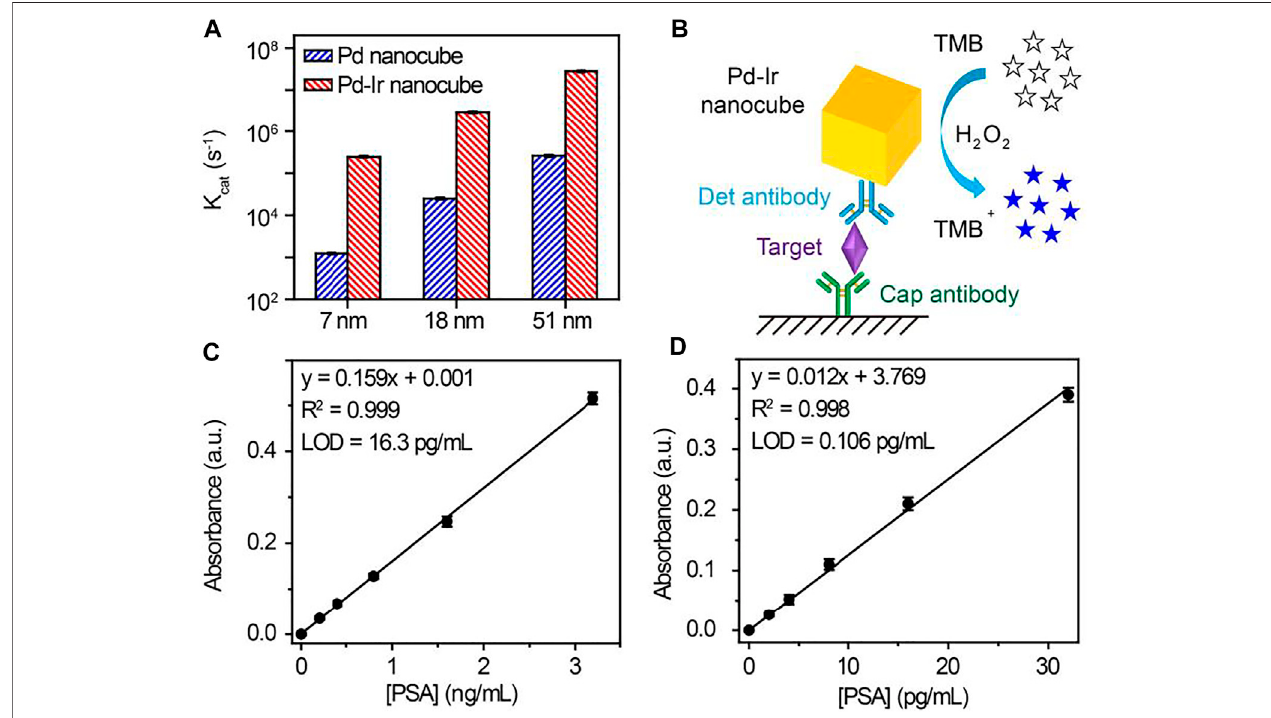
FIGURE 4 | (A) Catalytic rate constants of Pd and Pd-Ir nanocubes with different edge lengths. (B) Scheme of Pd-Ir nanocube-based ELISA for the detection of PSA. Signal responses of (C) HRP and (D) Pd-Ir nanocube-based ELISA for the detection of PSA. LOD (limit of detection) is de fi ned as the concentration of targets corresponding to a signal that is three times the standard deviation higher than zero calibrators (n (cid:1) 6).